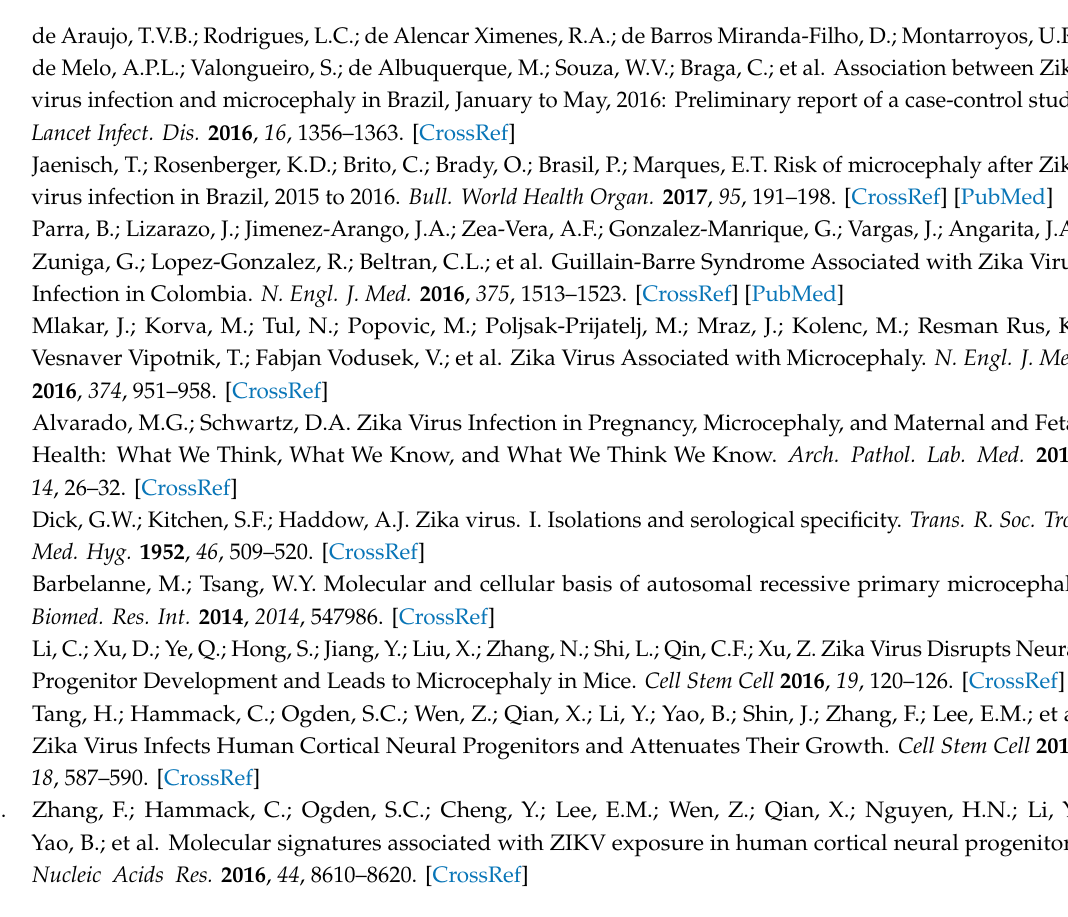
Figure S1: Detection of viral proteins in post-mortem brains, Figure S2: Dose-response curve of viral